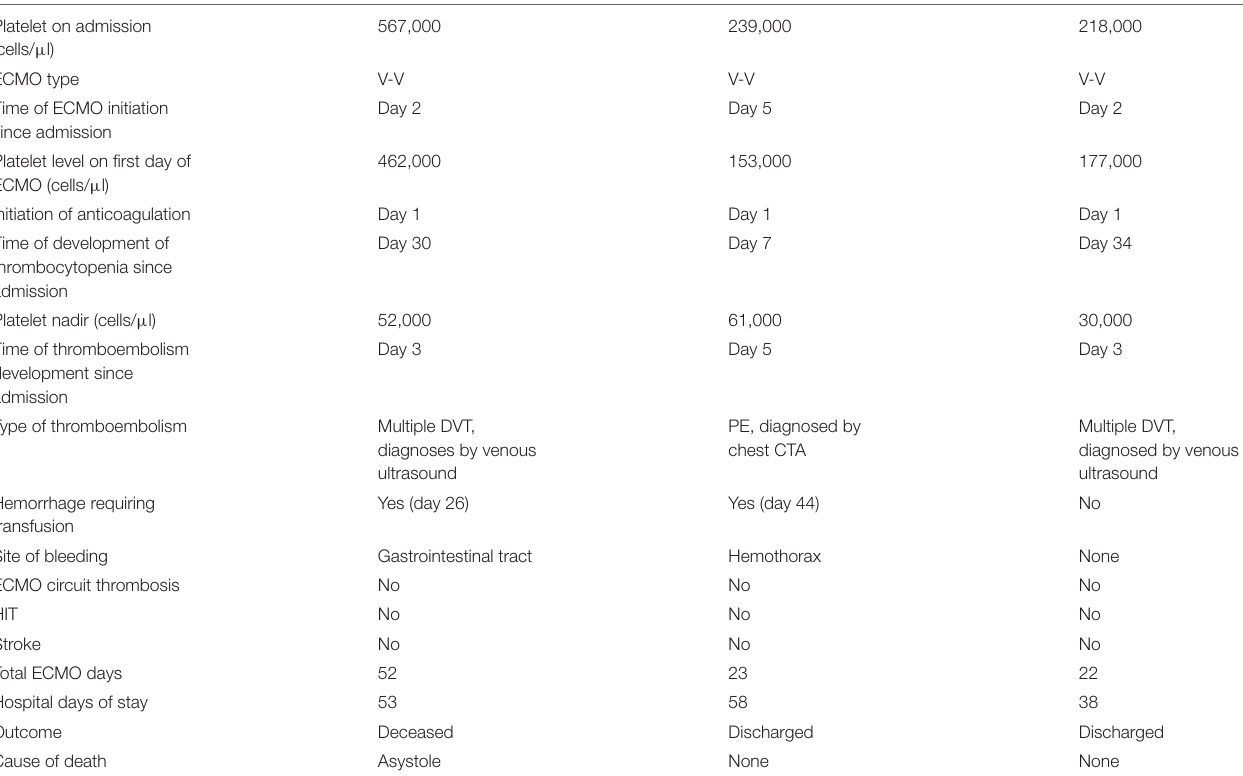
TABLE 3 | Thrombocytopenia and thromboembolic events on ECMO support. Platelet on admission (cells/ µ